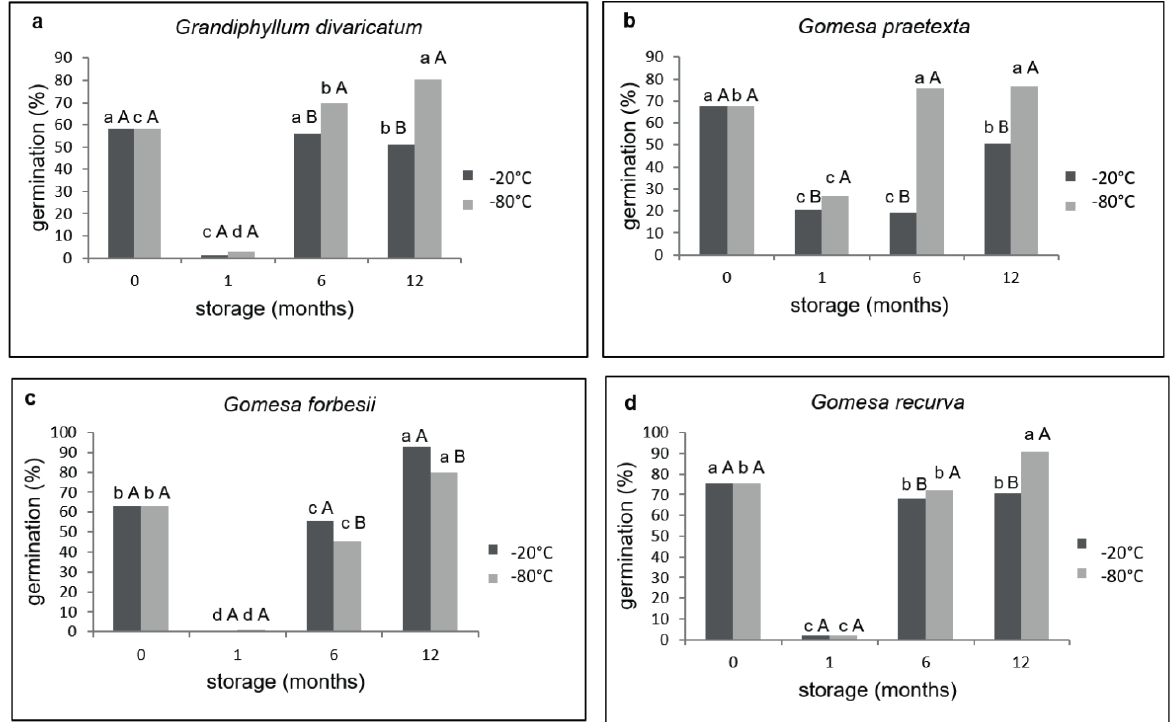
Figure 3 - Percentage of seed germination for a- Grandiphyllum divaricatum , b- Gomesa praetexta , c- Gomesa forbesii , and d- Gomesa recurva , storage at -20ºC and -80°C for 0, 1, 6 or 12 months. Lowercase letters indicate diff erences between storage times in the same temperature and uppercase letters indicate diff erences between storage temperatures in the same storage time, according to Tukey test (p